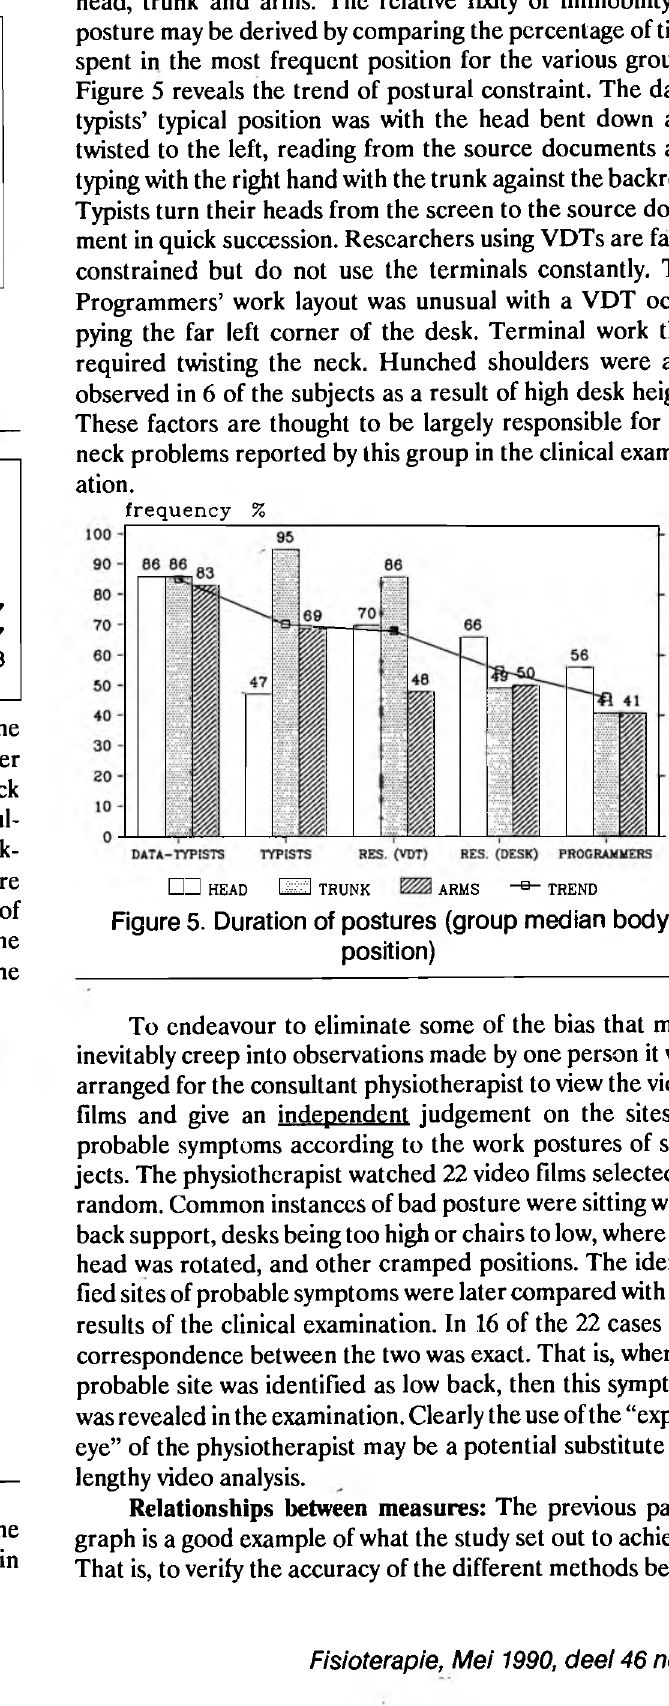
Figure 4. Postural change